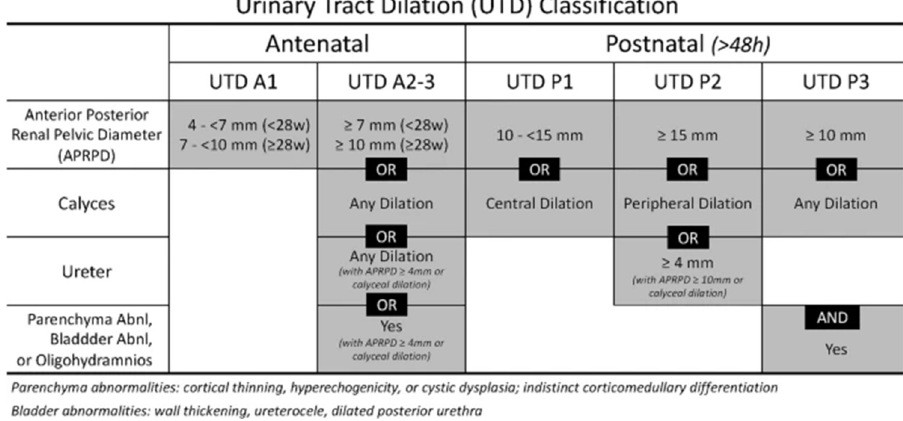
Figure 1. Table adapted from Nguyen, 2022, p.740 − 751 [9].